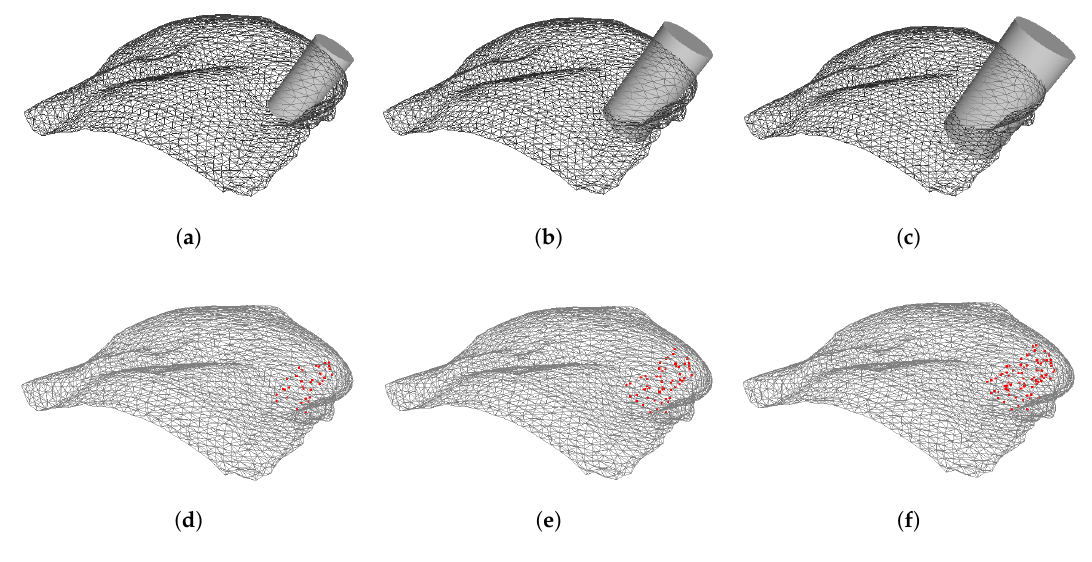
Figure 7. Definition of the cylinder to excise and the correspondent points labelled as damaged: small ( a , d ), medium ( b , e ) and large tumor sizes ( c , f